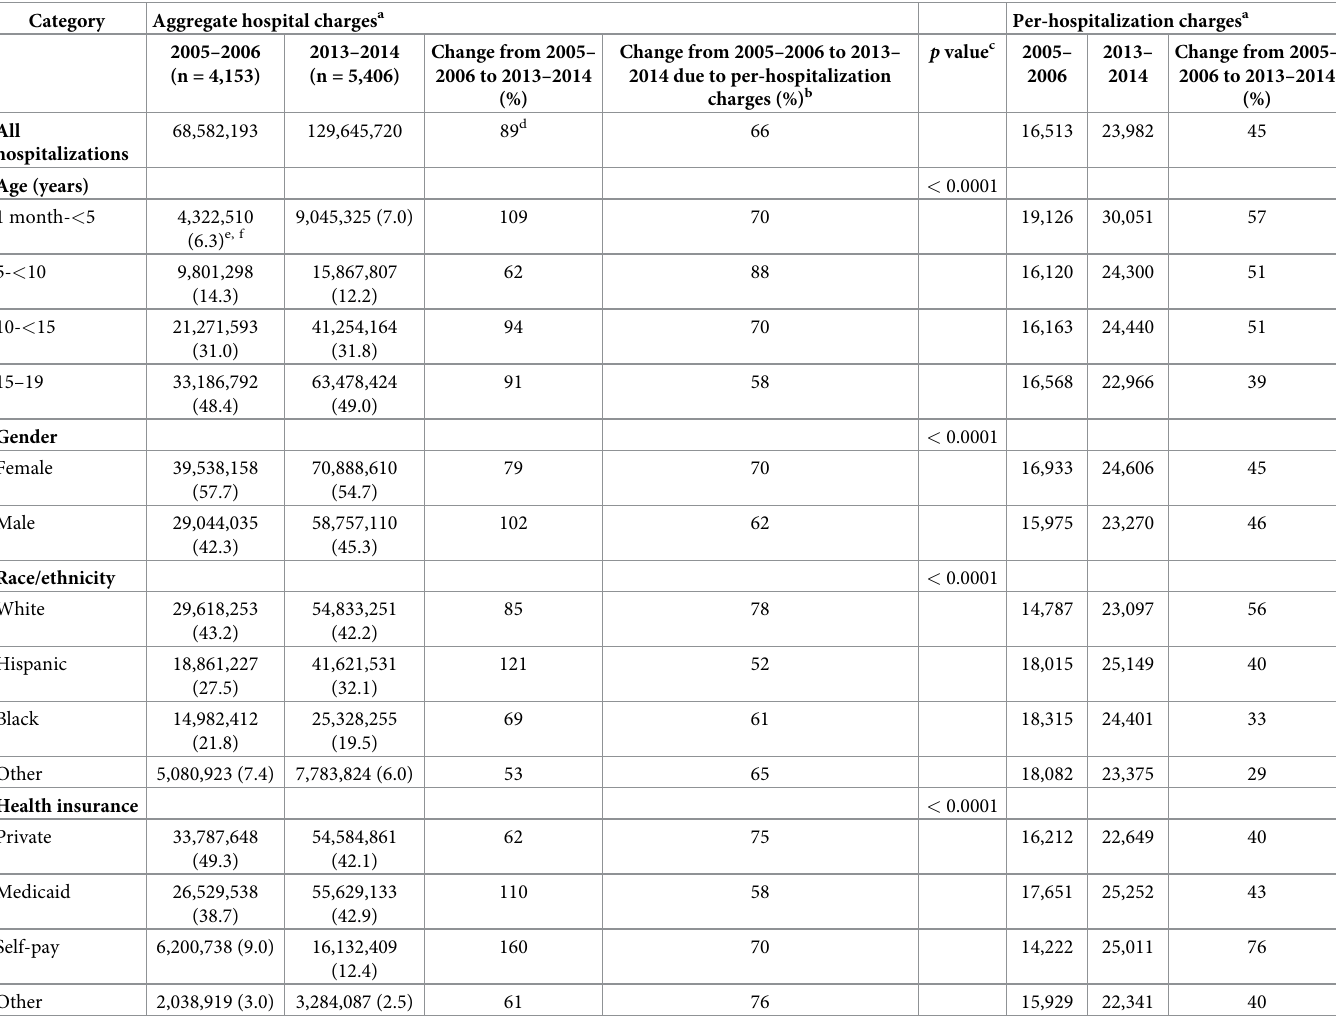
Table 4. Changes in the aggregate and per-hospitalization charges among hospitalizations with diabetic ketoacidosis in Texas.